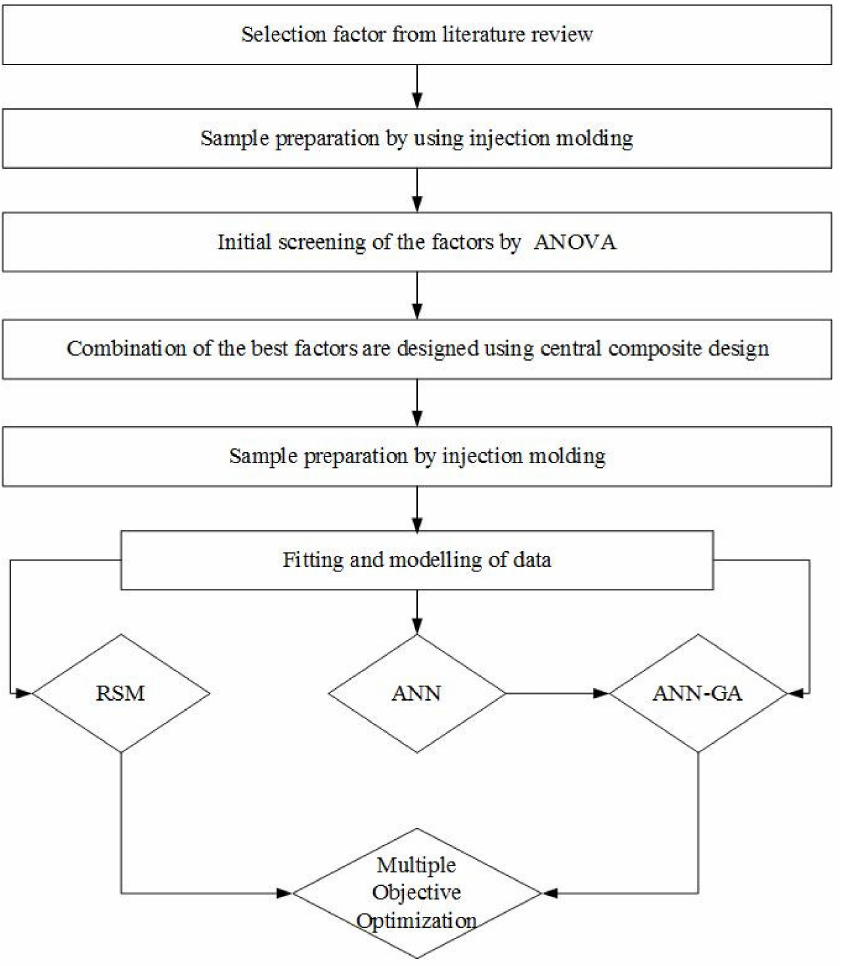
Figure 1. Flow diagram indicating the order of experimental design and the modeling